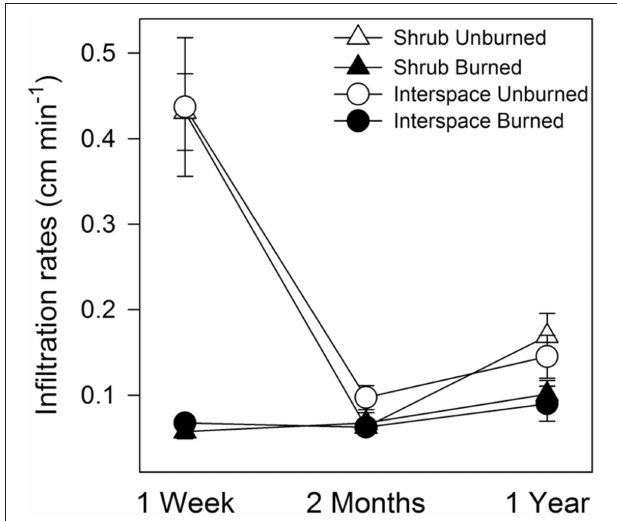
FIGURE 7 | Soil infiltration rates through biocrusts declined after fire. Values (cm min − 1 ) are means ( n = 5), ± SEM, reported in cm s − 1 . Differences are based on RM-ANOVA with attending F statistics and P -values for significant